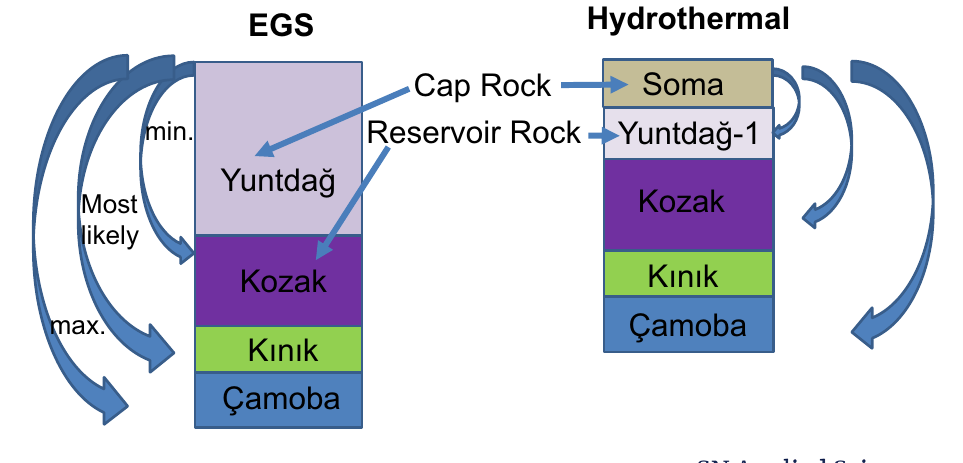
Fig. 5 Illustration of formation sequences of Kozak-EGS and Yuntdag hydrothermal system, and thickness definitions for the minimum, most likely and maximum estimates (not to